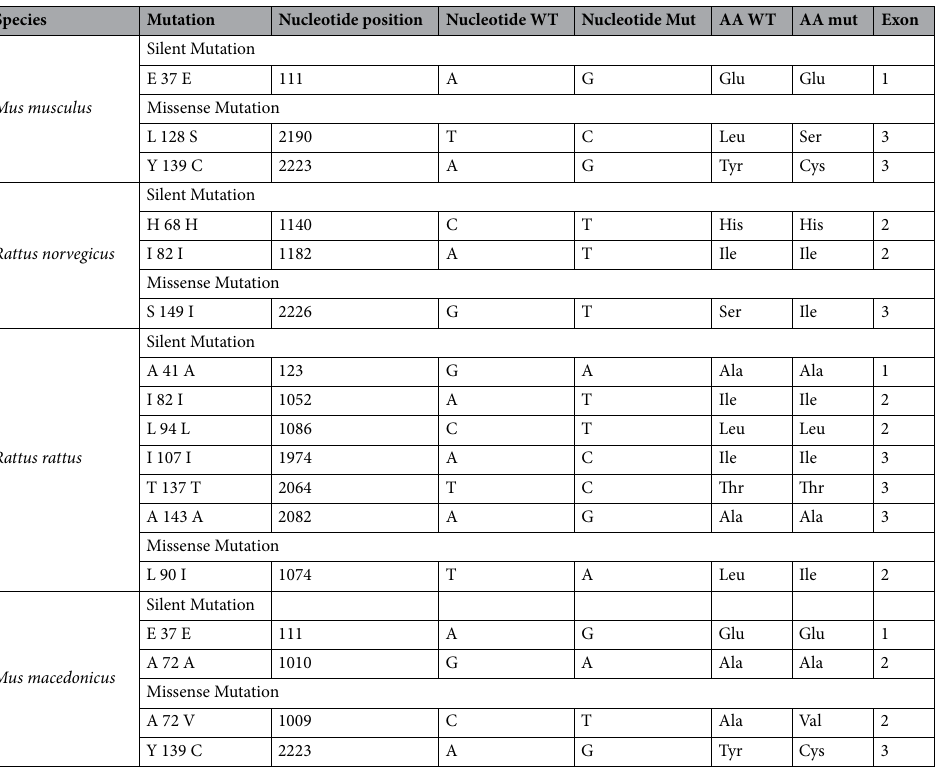
Table 2. Details of Vkorc1 mutations found in Lebanese rodents. WT Wild-type sequence; Mut Mutated; AA Amino